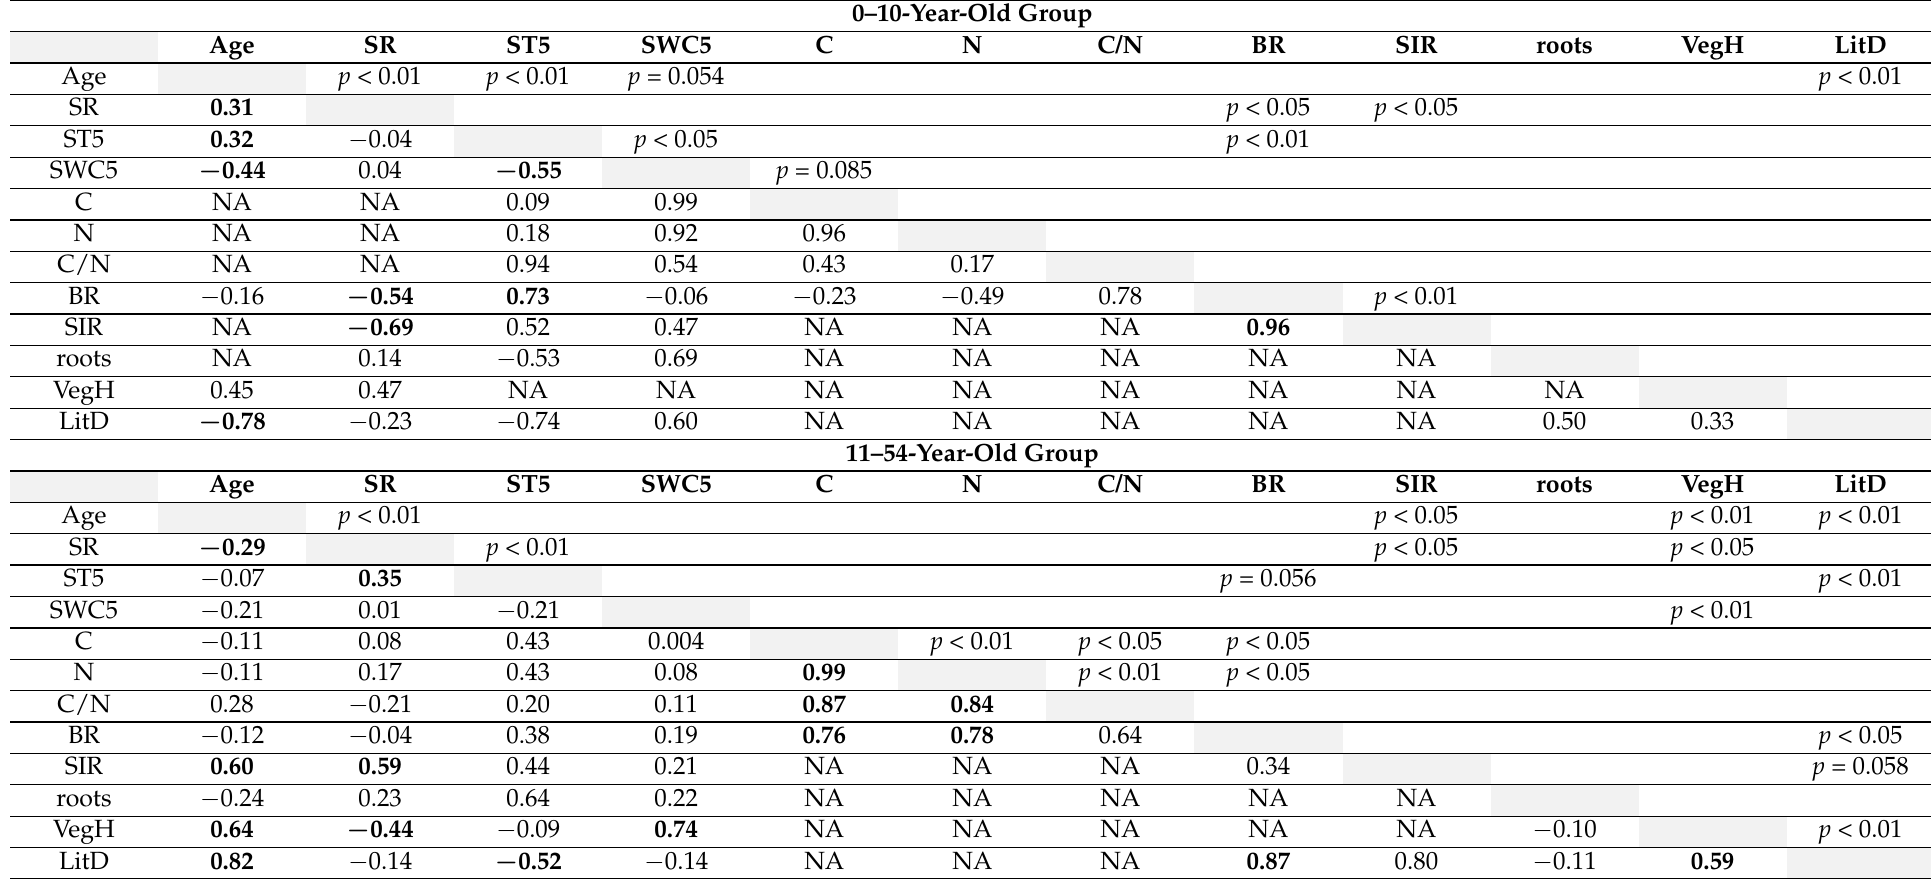
Table 5. Correlation analysis performed on various age groups (0–10, 11–54, 88–141, and 150–276-years-old groups) by the means of Pearson’s product-moment correlation coefficients (significant at p < 0.05 and at p < 0.01). SR, soil respiration; ST5, soil temperature; SWC5, soil water content; C, soil C content; N, soil N content; C/N, soil C/N ratio; BR, soil basal respiration; SIR, soil substrate-induced respiration; roots, root biomass; VegH, vegetation cover height; LitD, litter thickness; Age, stand age; NA, no data